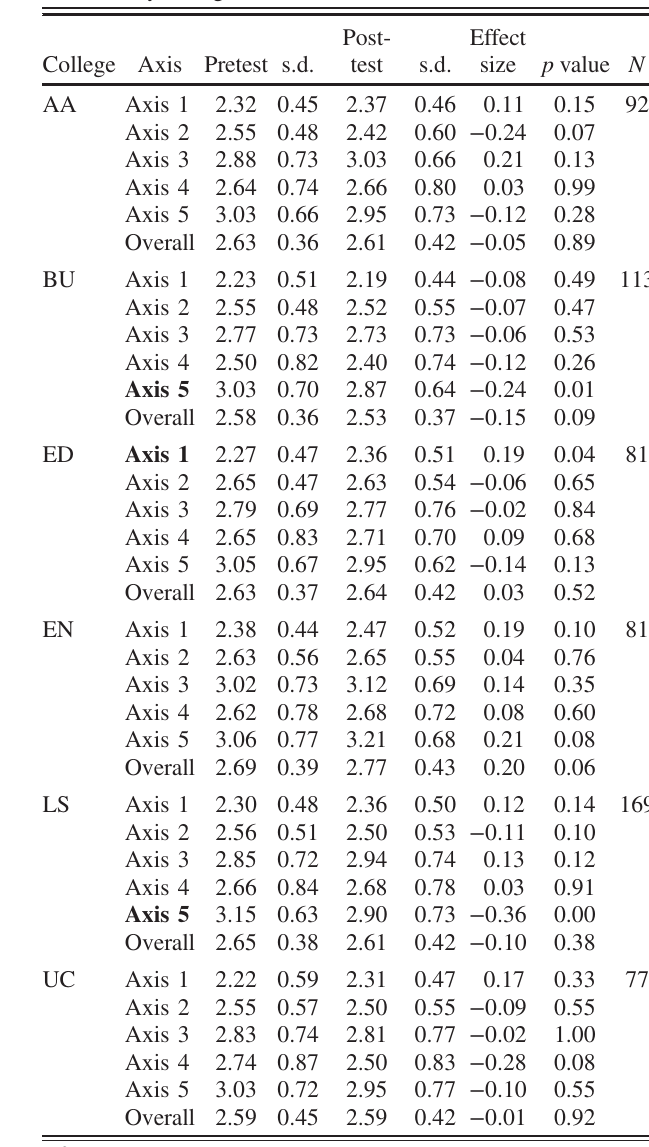
TABLE V. EBAPS pretest and post-test results for spring modified by college. a